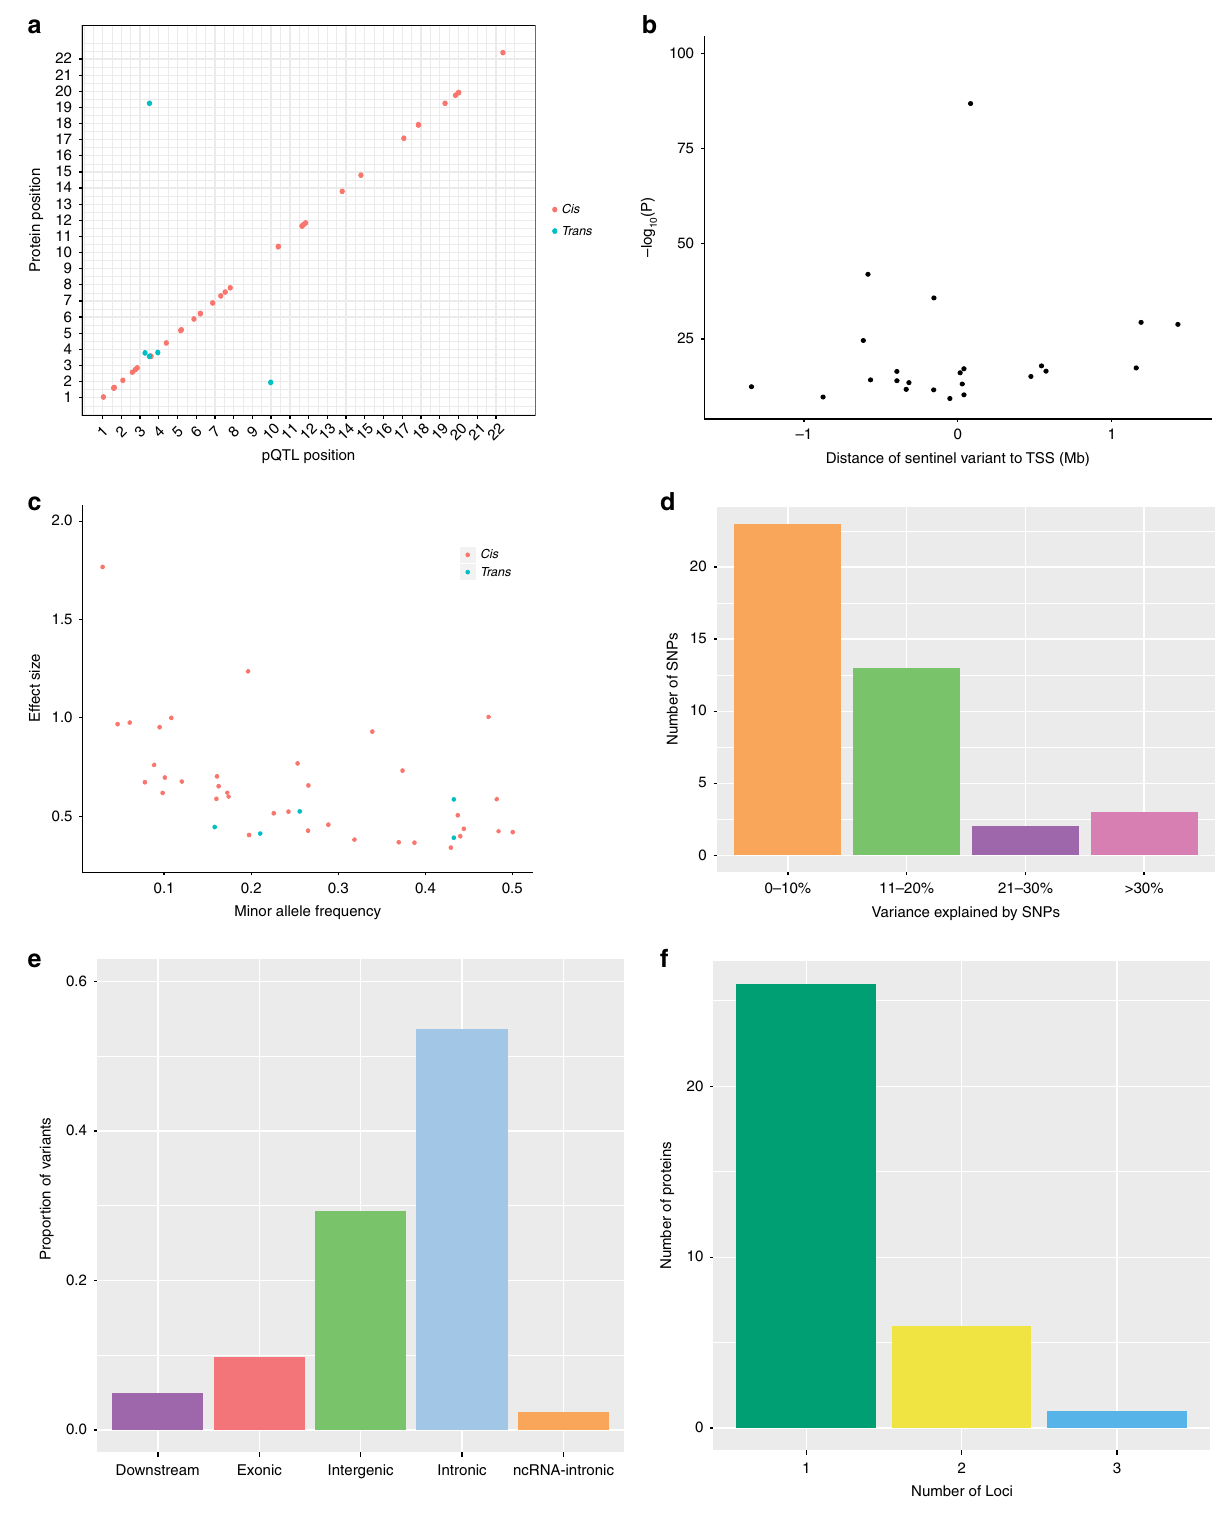
Fig. 1 Genome-wide association study of neurological protein biomarkers. a Chromosomal locations of pQTLs. The x -axis represents the chromosomal location of conditionally signi fi cant cis and trans SNPs associated with the levels of Olink ® neurology proteins. The y -axis represents the position of the gene encoding the associated protein. Cis (red circles); trans (blue circles). b Signi fi cance of sentinel cis variants versus distance of variants from the gene transcription start site. c Absolute effect size (per standard deviation of difference in protein level per effect allele) of conditionally signi fi cant pQTLs versus minor allele frequency. Cis (red circles); trans (blue circles). d Variance in protein levels explained by conditionally signi fi cant pQTLs. It is important to note that these estimates may be in fl ated owing to winner ’ s curse or over- fi tting in the discovery GWAS. e Classi fi cation of pQTL variants by function as de fi ned by functional enrichment analysis in FUMA. f Number of conditionally signi fi cant pQTL variants per Olink ® neurology